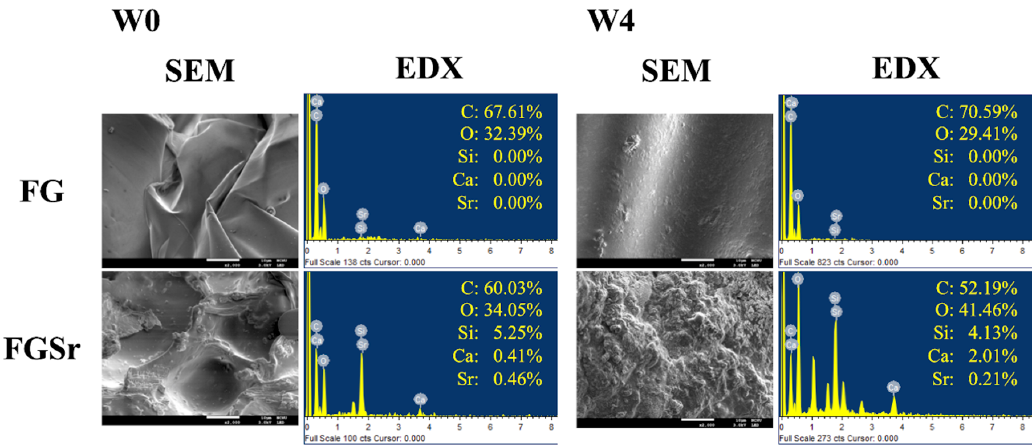
Figure 5. Microstructure images of the FG and FGSr scaffolds and evolution of different ions by energy dispersive spectroscopy before and after immersion in SBF. The scale bar is 10 μ m.